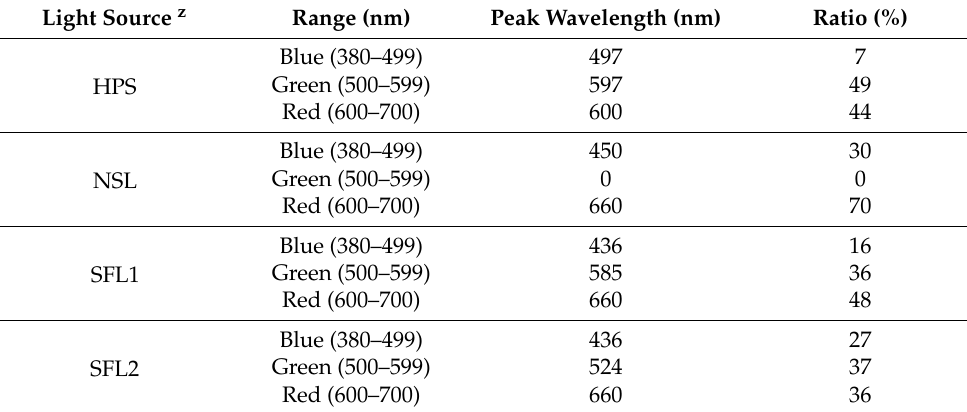
Table 2. Peak wavelengths and spectral ratio of each SL source.